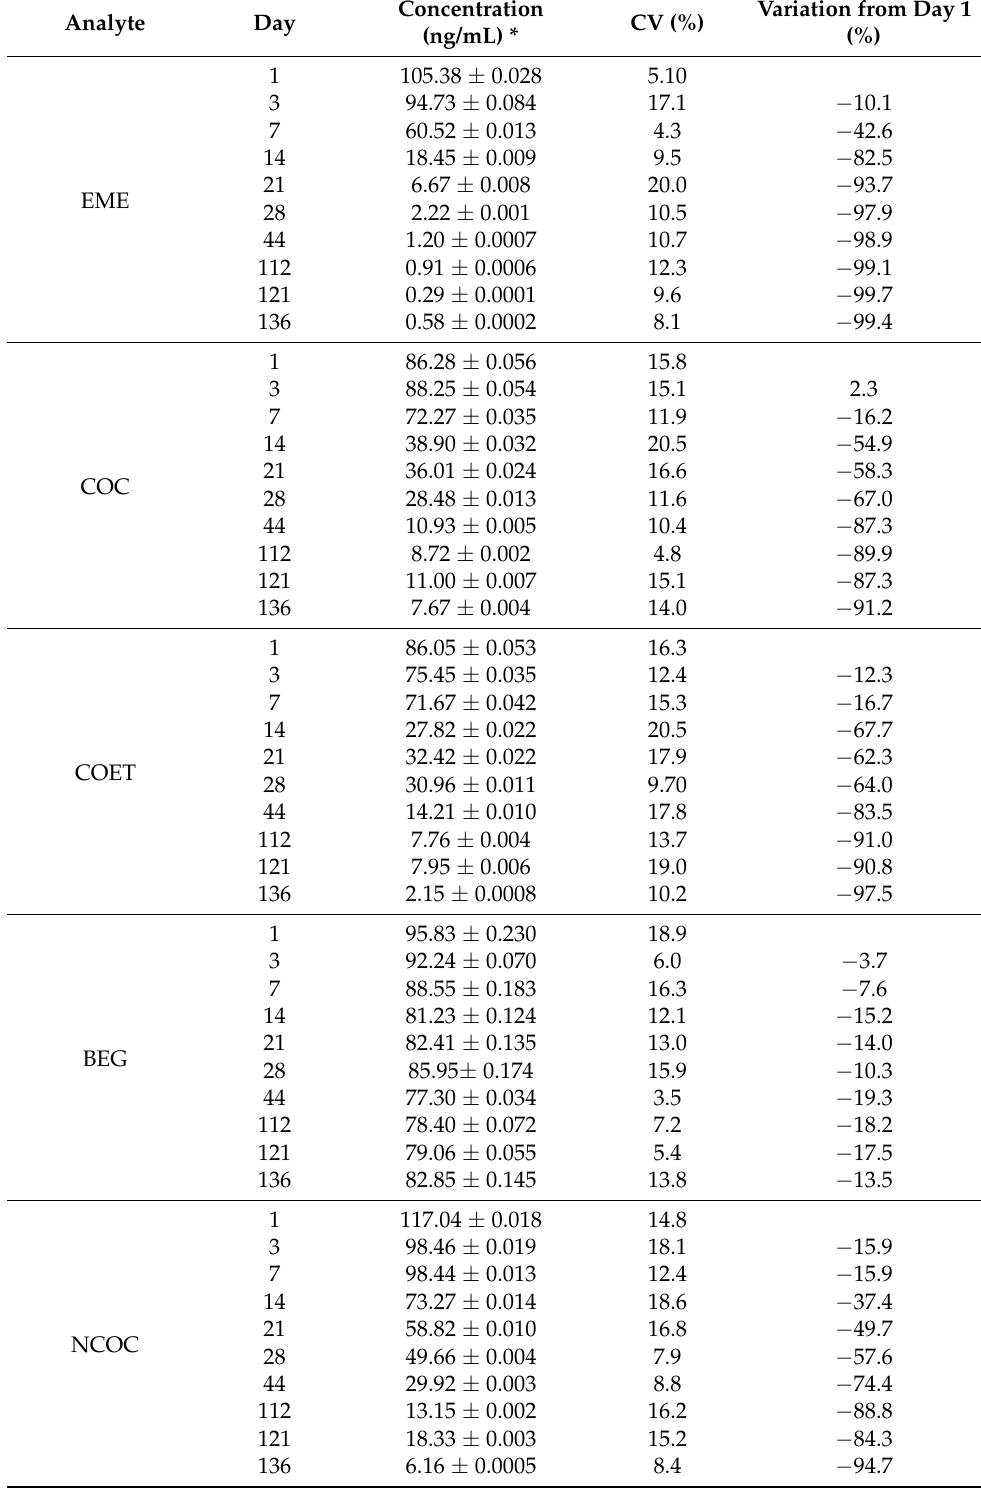
Table 4. Long-term stability ( n =